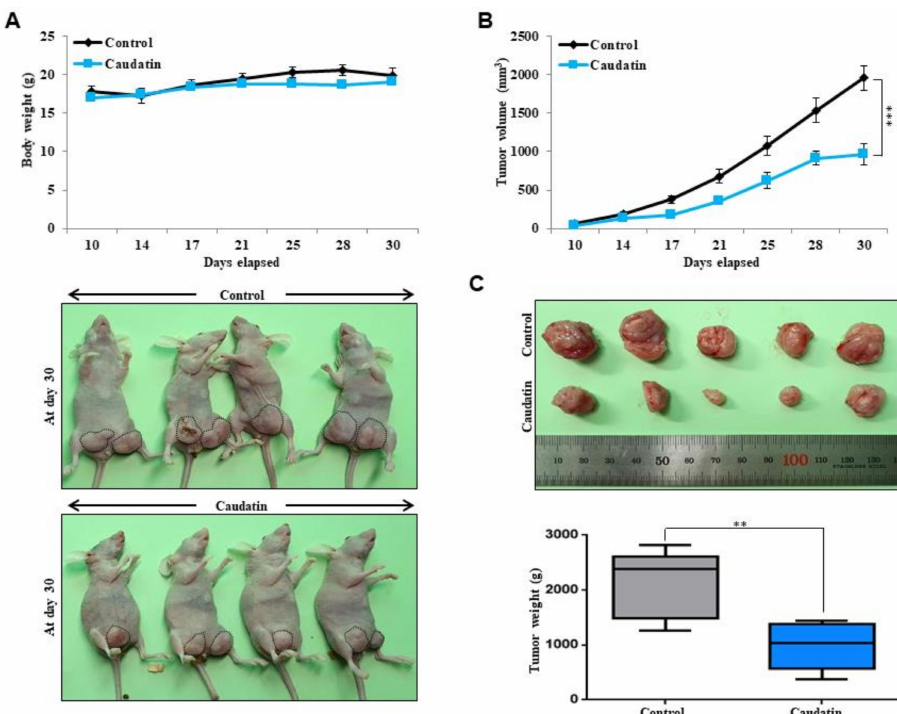
Figure 4. The e ff ect of caudatin on tumor growth in a mouse model. MDA-MB-231 cells (2 × 10 6 cells / mouse) were injected into the mammary fat pad of female nude mice and treated with caudatin (10 mg / kg) or DMSO (control group, n = 6). ( A ) The body weights of the mice in the caudatin-treated group were comparable to those of the mice in the control group. On day 30, images of the mice in the control and caudatin-treated groups were captured with a camera. ( B ) Tumor volume was measured using a caliper and calculated as (width 2 × length) / 2 at the indicated time points. ( C ) On day 30, the tumor weights of the control and caudatin-treated mice were assayed after sacrifice. The data are presented as the mean ± SD of three independent experiments. ** p < 0.01 and *** p < 0.001 versus the DMSO-treated control